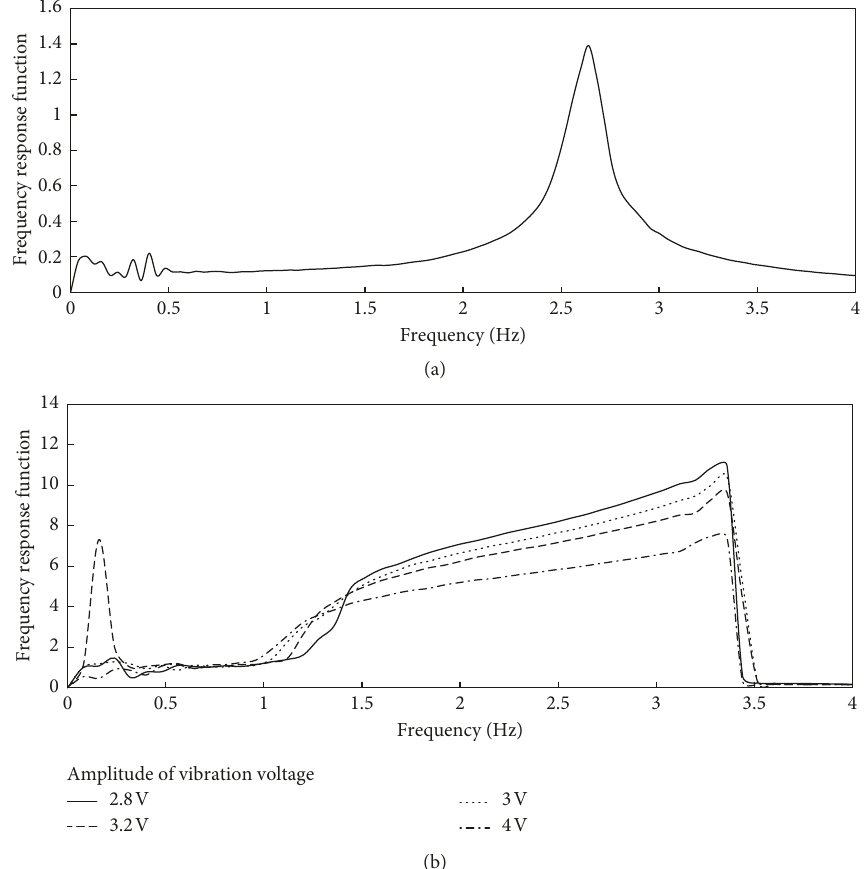
Figure 11: Frequency responses of the model offshore platform and magnet damper. Frequency response of the (a) model offshore platform and (b) magnet damper at different vibration amplitudes.